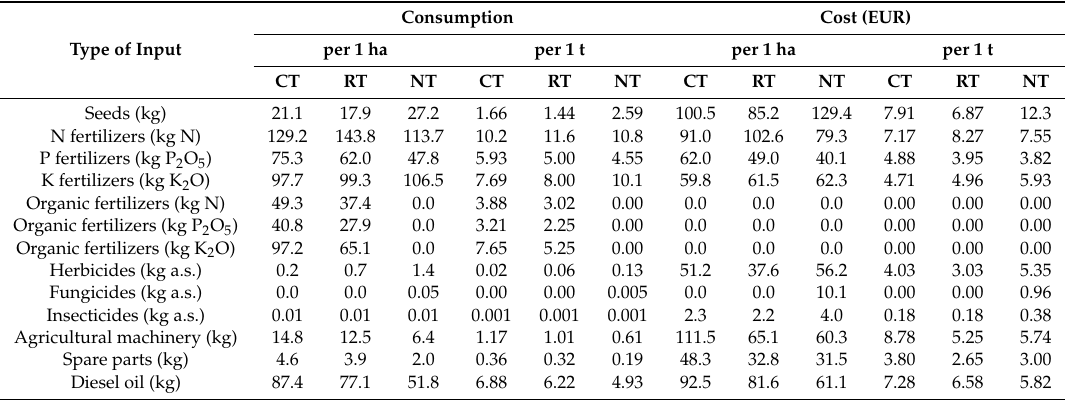
Table 2. Inventory data of main inputs and internal costs for grain maize production in conventional tillage (CT), reduced tillage (RT) and no-tillage (NT) systems.